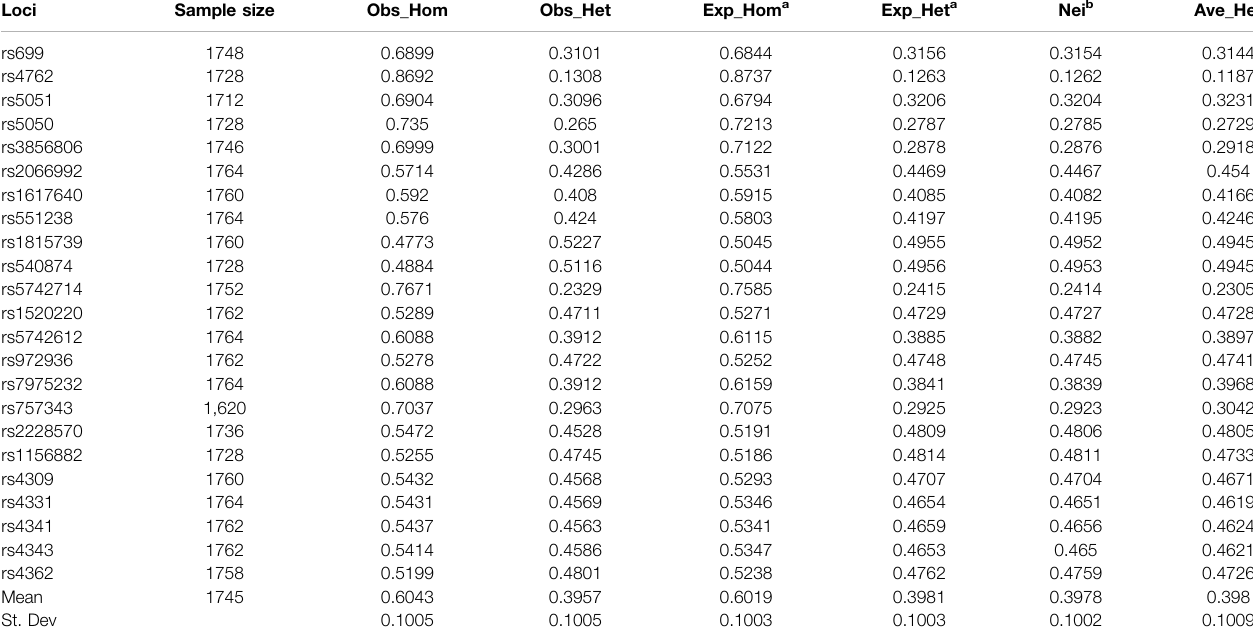
TABLE 4 | summary of heterozygosity statistics for 23 SNPs. Loci